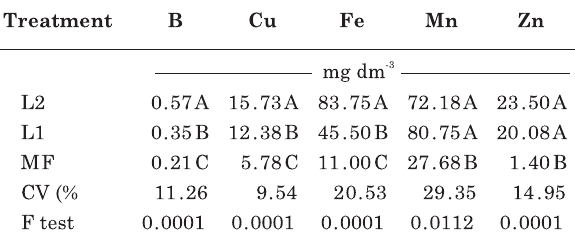
Table 4. Soil micronutrient availability at the 0– 0.20 m depth layer, in plots treated with sewage